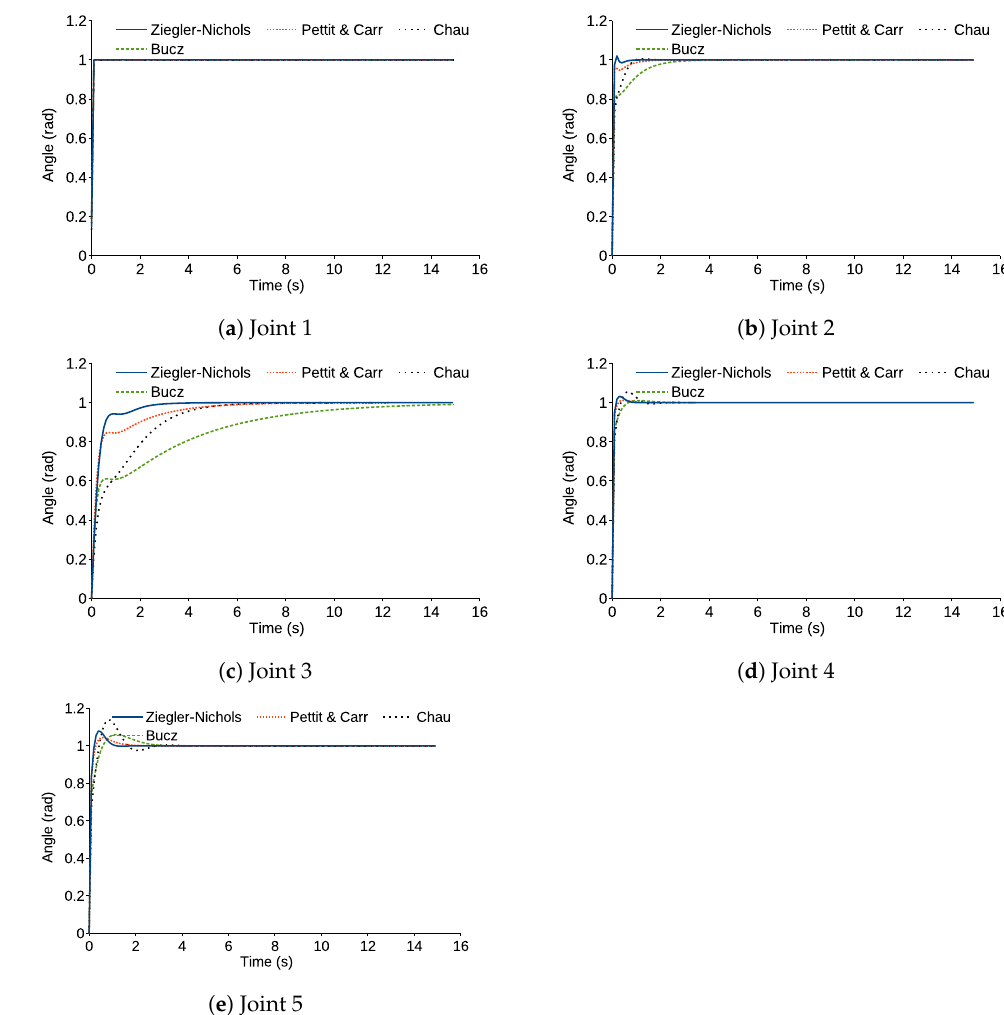
Figure 4. Unit step response of tuned closed-loop control